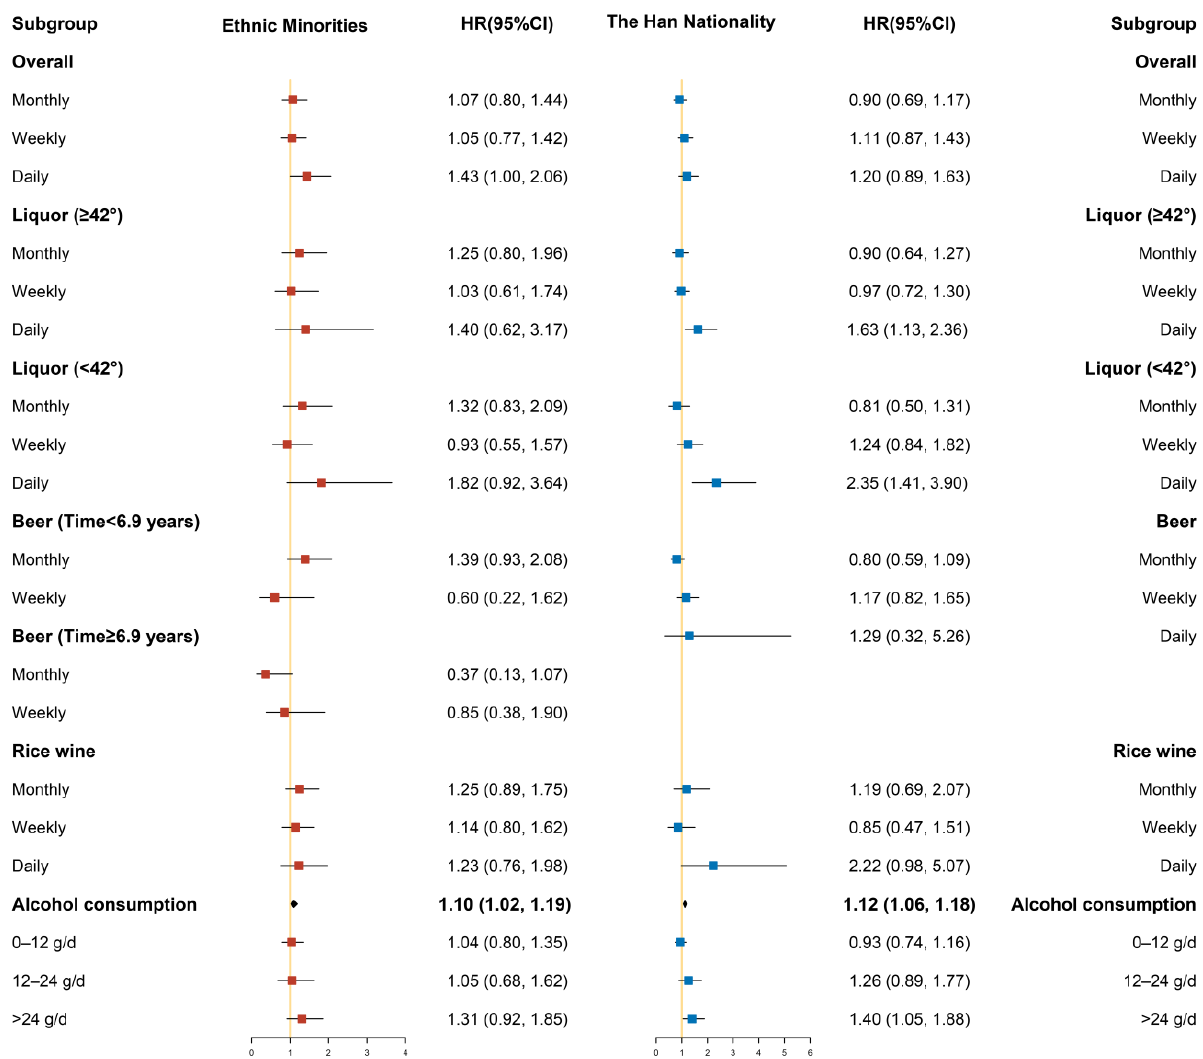
Figure 3. Subgroup analysis after stratification by ethnic minority and the Han nationality (Model 3).